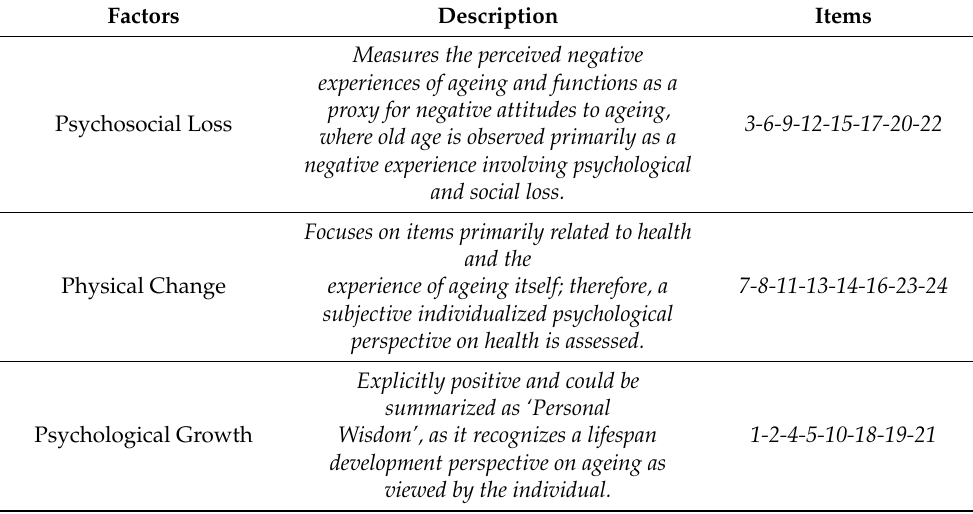
Table 1. Dimensions, description, and corresponding items from the original tri-factorial version of the AAQ [9].